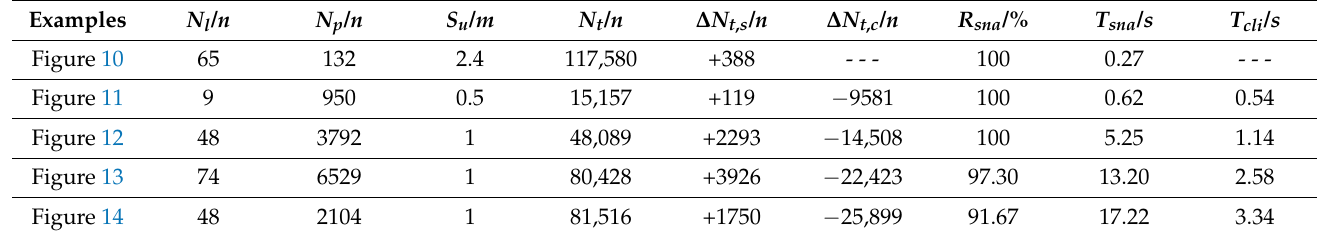
Table 1. Experimental data statistics, including the constraint polyline number ( N l ), the constraint point number ( N p ), the model unit size ( S u ), the triangular patch number of the original model ( N t ), the change in the number of triangular patches before and after snapping the model’s features ( ∆ N t , s ), the change in the number of triangular patches before and after clipping the model’s boundary ( ∆ N t , c ), the model snapping ratio ( R sna ), the model snapping time ( T sna ), and the boundary clipping time ( T c L i